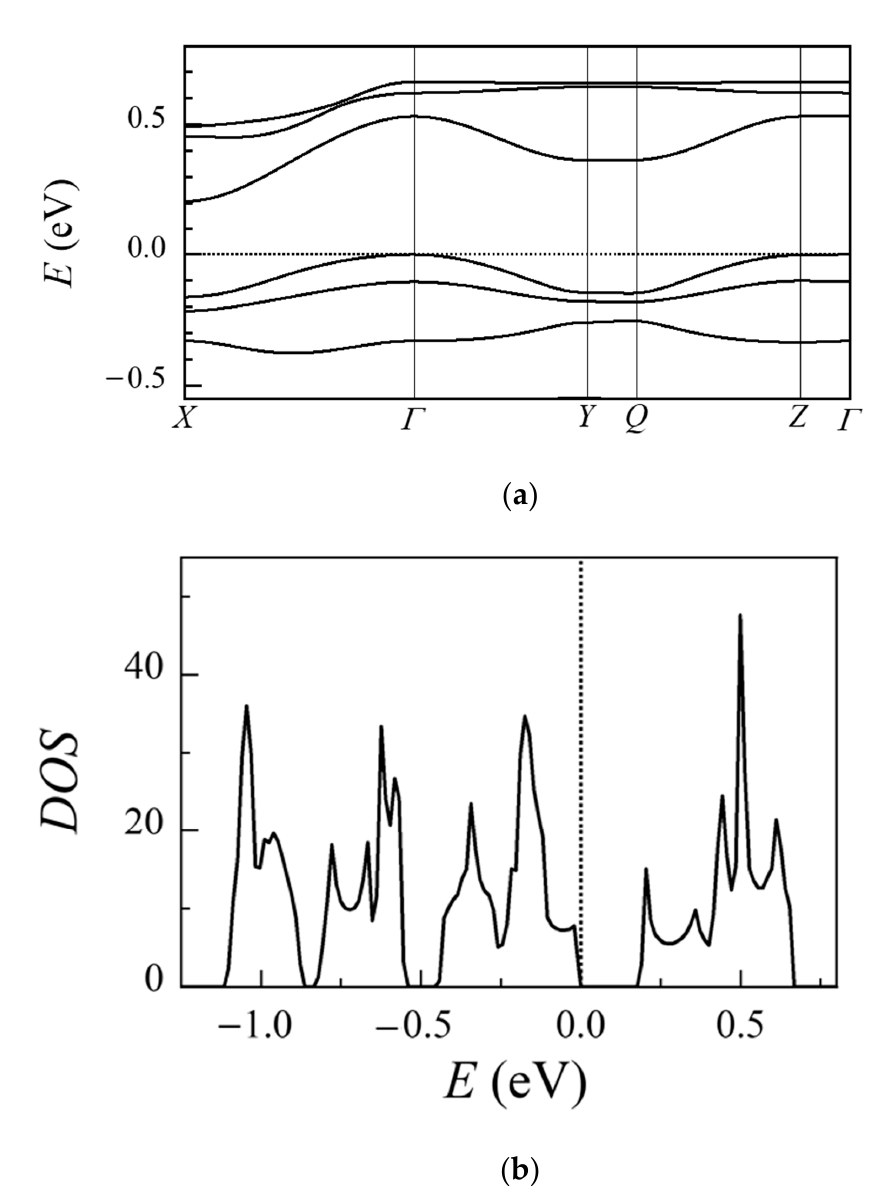
Figure 6. ( a ) The band energy dispersion curve of 2 . The symbols Γ , X , Y , Z , and Q represent the following positions in the reciprocal space: Γ (0,0,0), X ( 1 / 2 ,0,0), Y (0, 1 / 2 ,0), Z (0,0, 1 / 2 ), and Q (0, 1 / 2 , 1 / 2 ). ( b ) The density of states (DOS) of 2